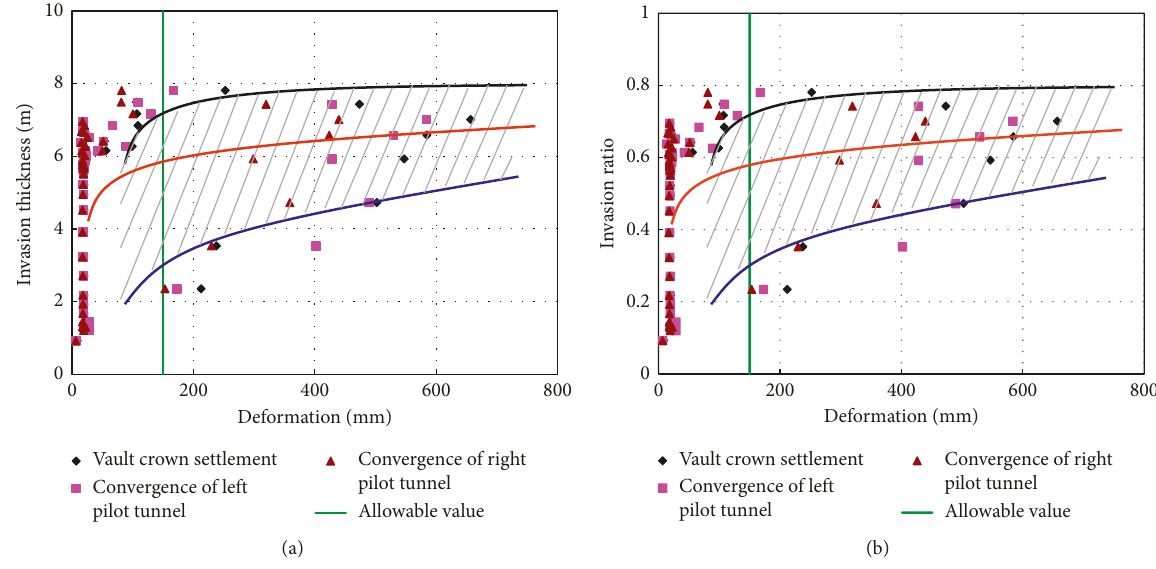
Figure 9: Relation between the surrounding rock deformation and invasion thickness and invasion ratio: (a) invasion thickness; (b) invasion